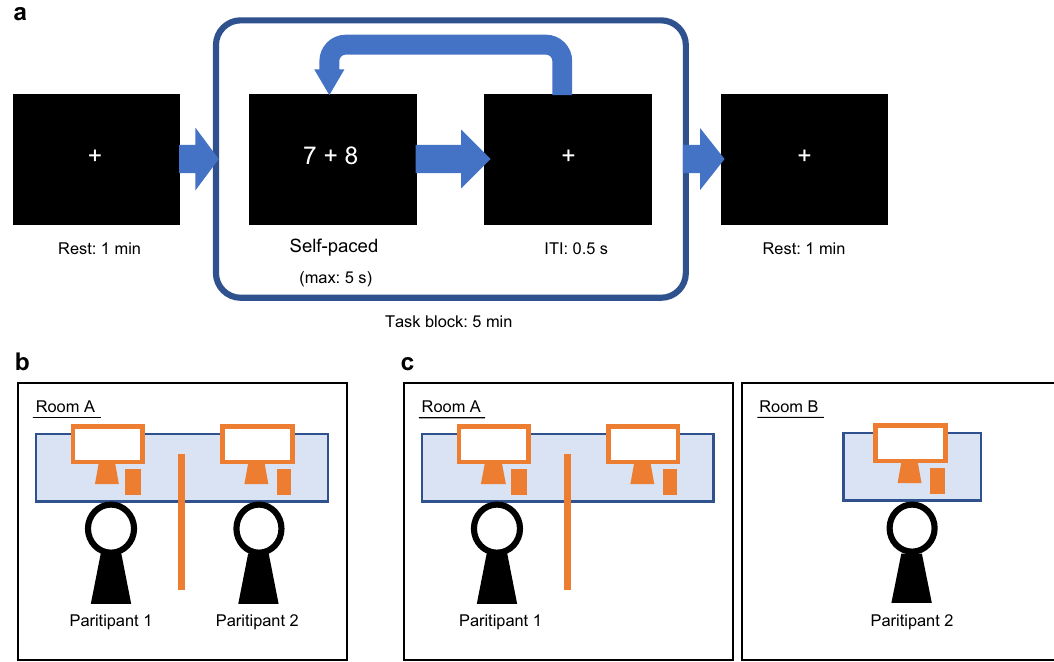
Figure 3. Overview of experimental design. ( a ) Timeline of each experimental run. The trials proceeded at each participant’s own pace, with a maximum duration for each of 5 s; the inter-trial interval was set at 0.5 s, and the duration of the trial block was 5 min. ( b ) Experimental environment of the adjacent condition. Each pair of participants performed the experimental task next to each other in the same room. ( c ) Experimental environment of the solitary condition. One of the participants was moved to another room, and both performed the experimental task